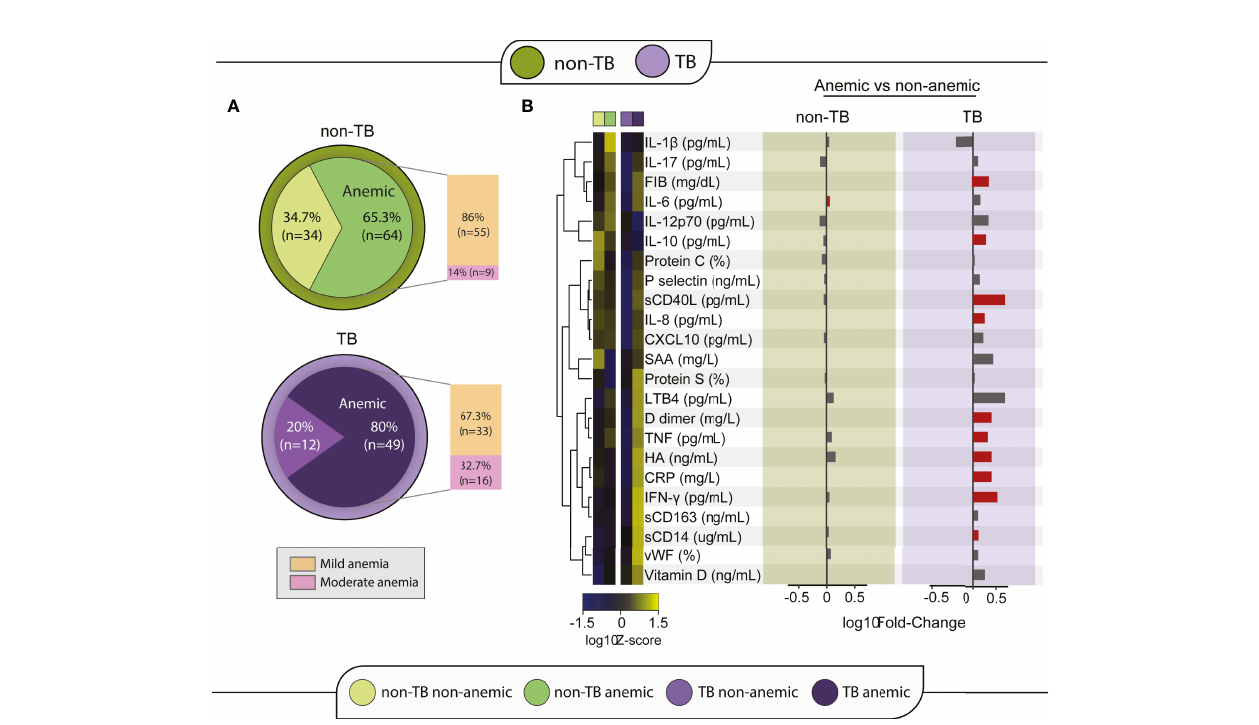
FIGURE 1 | Anemia is linked to a differential in fl ammatory pro fi le in TB-HIV participants. (A) Participants of each group were divided according to anemia status and grade. To de fi ne anemia grade, the cut-off point for hemoglobin of 12 g/dL for women and 13 g/dL for men was used to de fi ne normal levels, the cut-off of 10 g/dL and lower than normal levels was used for mild anemia and hemoglobin between 8 and 10 g/dL was classi fi ed as moderate anemia. (B) A heatmap was designed to depict the overall pattern of in fl ammatory markers. A one-way hierarchical cluster analysis (Ward ’ s method) was performed. Dendrograms represent Euclidean distance. Right panel: A log10 of fold-change was calculated and statistical analyses were performed using the Mann – Whitney U adjusted test. Signi fi cant differences (p < 0.05) between groups are highlighted in red